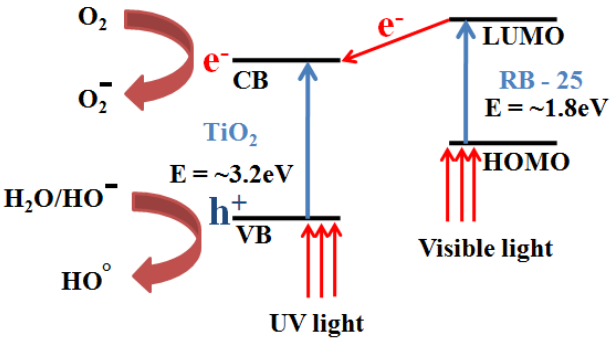
Figure 7. Schematic diagram of mechanism of dye ‐ sensitized TiO 2 acting as a photo ‐ catalyst.